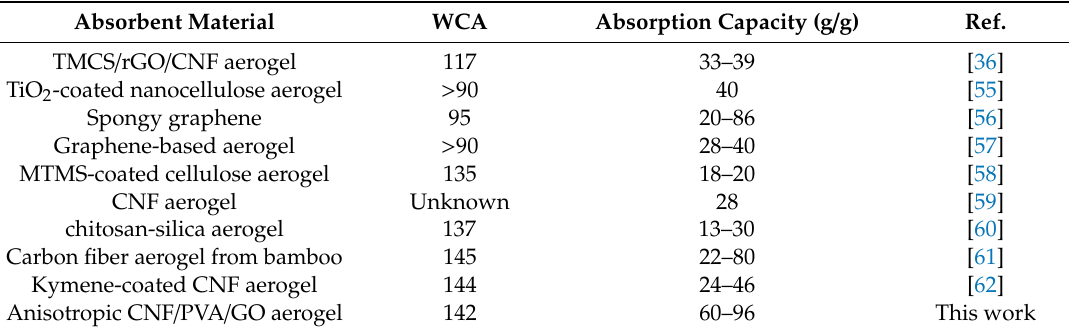
Table 2. Comparison of the absorption capacities of di ff erent materials.